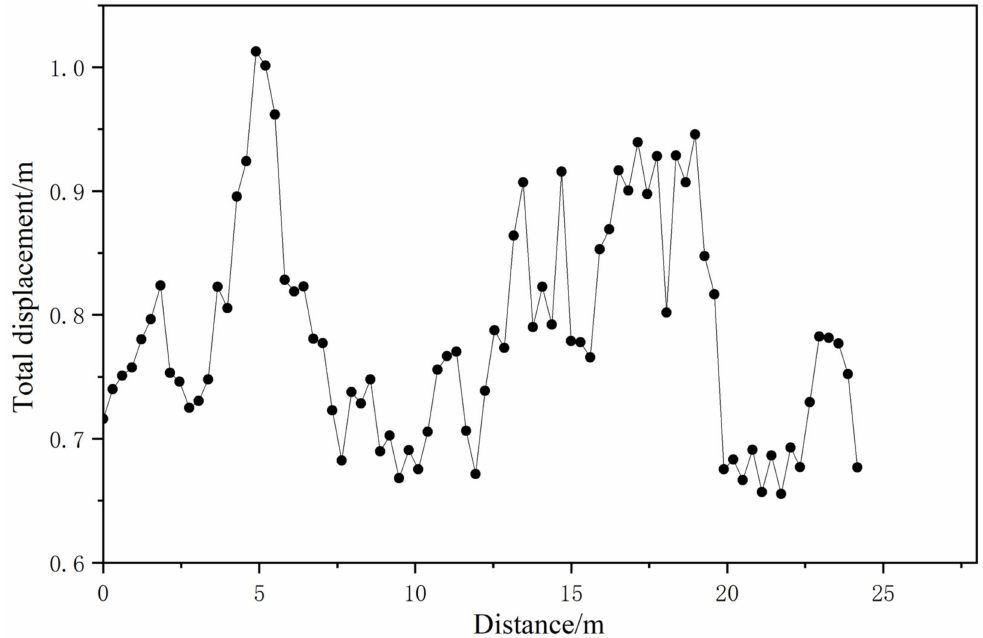
Figure 9. Displacement curve of the shaft without support.